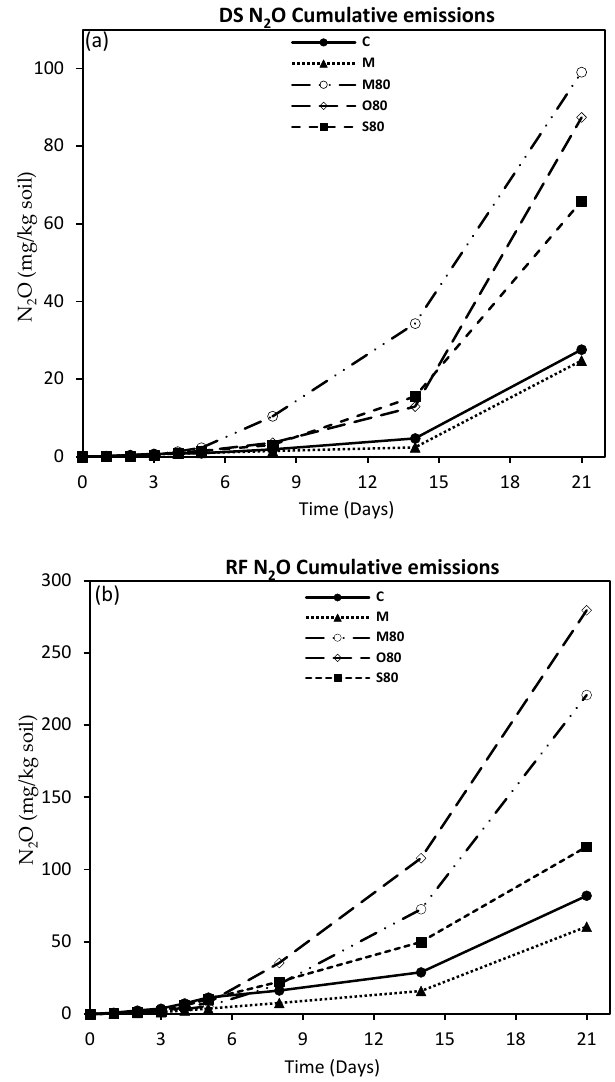
Figure 4. Cumulative N 2 O emissions from four cropping treatments on ( a ) Dry Savanna, DS , and ( b ) Rainforest, RF , soils. C = control, M = manure treatment, M80 = Manure + 80 kg N / ha, O80 = No manure + 80 kg N / ha S80 = soil pot microdosed with 80 kg N / ha without any vegetables. (n = 3).